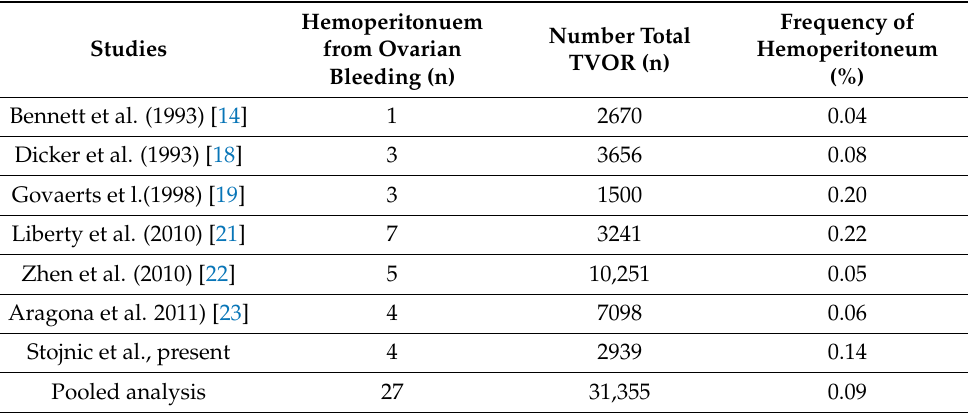
Table 5. Pooled analysis of eight studies that investigated the frequency of ovarian bleeding caused hemoperitoneum after transvaginal oocyte